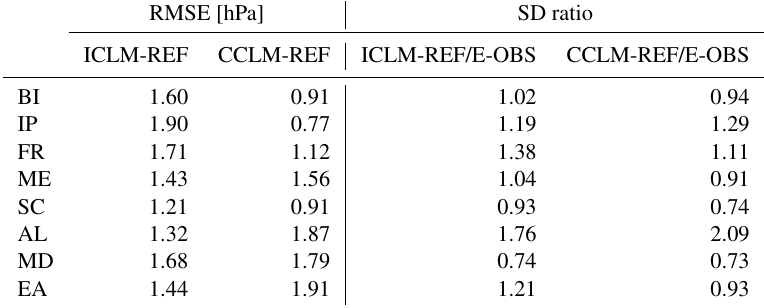
Table 8. Same as Table 4 but for MSLP.